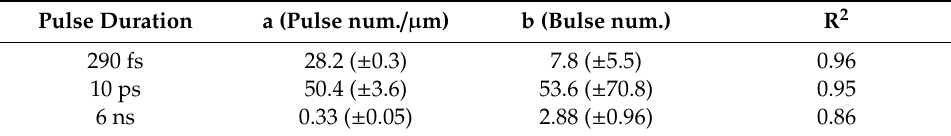
Table 1. Fit parameters for the data set shown in Figure